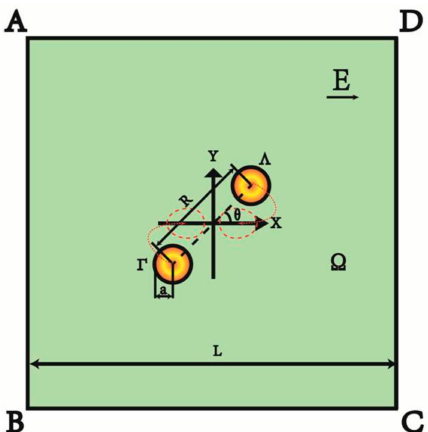
Figure 1. Two identical particles suspended in a square domain Ω under an externally applied electric field E . The origin of the 2D Cartesian coordinate systems ( x , y ) is located at the midpoint of the connecting line of the two particles and the center of the square. The particle radius and the distance between the two particles are denoted by A and R, respectively. The angle between the connecting line of the two particles and the x -axis is denoted by θ . The surfaces of the particles in the first quadrant and the third quadrant are denoted by Λ and Γ , respectively. The dashed lines show the locations and shapes of the two particles. The dotted lines show the trajectories of the interaction